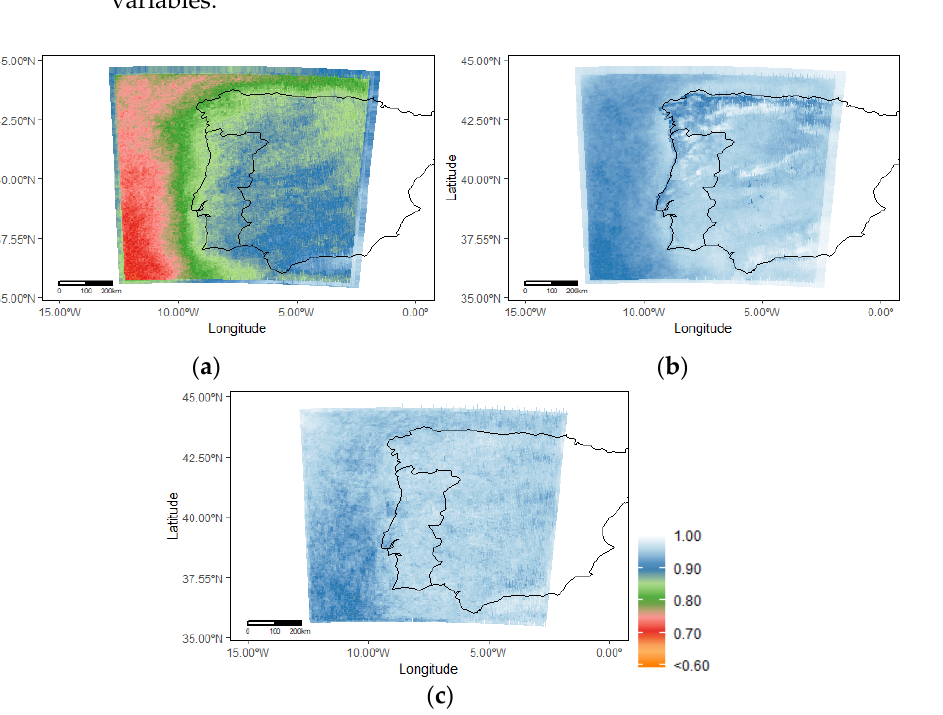
Figure 2. Spatial variability of agreement ( A ) between the WRF-Chem simulations, with and without aerosol feedback, for the analysed meteorological variables: ( a ) solar radiation; ( b ) air temperature; and ( c ) precipitation.